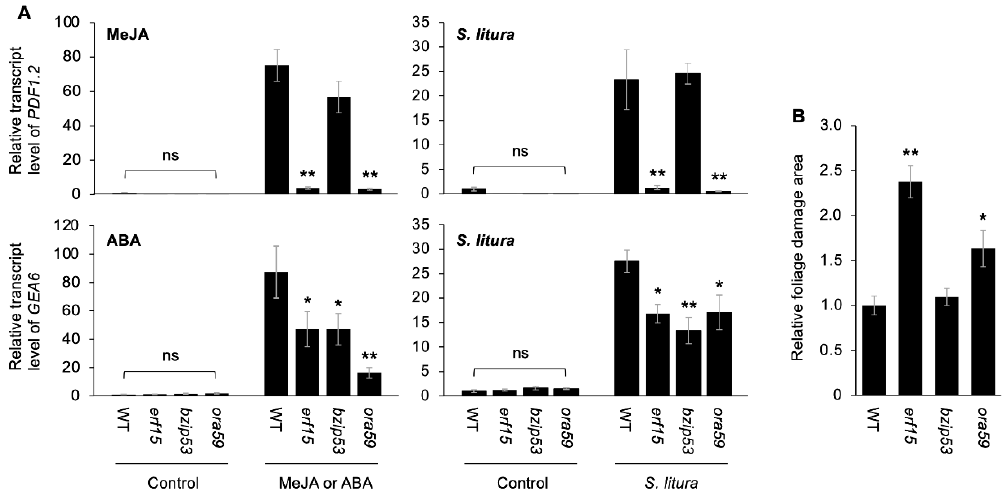
Figure 2. Anti-herbivore traits of JiTF -deficient mutant plants. ( A ) Relative transcript levels of PDF1.2 and GEA6 in leaves of wild-type (WT) Arabidopsis thaliana plants and T-DNA insertion mutant plants, corresponding to the respective JiTFs (JiTF3 [ erf15 ], JiTF5 [ bzip53 ], and JiTF7 [ ora59 ]), were exposed to methyl jasmonate (MeJA) for 12 h, abscisic acid (ABA) for 6 h, or Spodoptera litura larvae for 24 h. Plants with application of aqueous solution (0.1% ethanol) alone for 12 h and for 6 h and uninfested healthy plants served as control for MeJA, ABA and S. litura -exposed plants, respectively. ( B ) Foliage damage areas of mutant plants, relative to those of WT plants, were assessed after incubation with S. litura larvae for 24 h. Data represent the mean and standard error ( n = 6 and 20 for ( A ) and ( B ), respectively). Data marked with an asterisk(s) are significantly different from those in WT among each data set, based on an ANOVA with Holm’s sequential Bonferroni post hoc test (**, p < 0.01; *, 0.01 ≤ p < 0.05). ns, not significant.